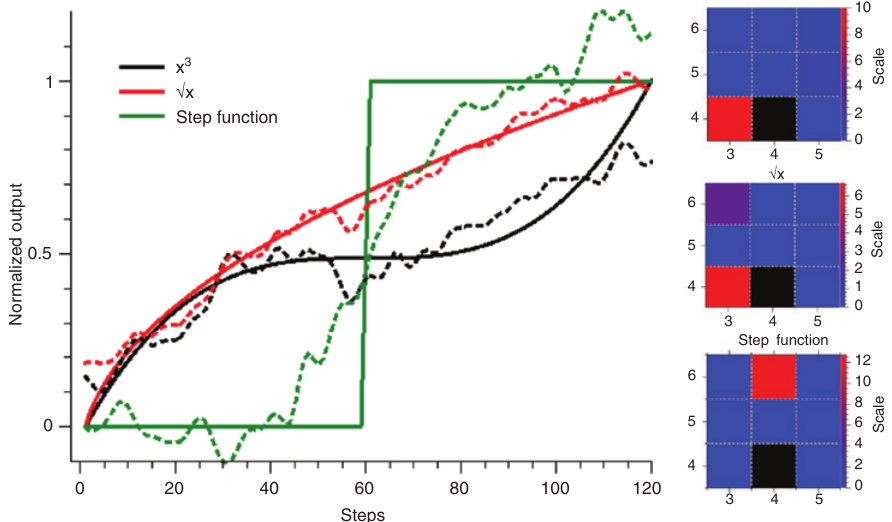
Figure 5: Several nonlinear transformations were synthesized from the network of eight injection locked lasers [24]. The y axis corresponds to rescaled values of optical intensities, the x axis to sample points of the input signal (sampling time 100 ps). The right panels show the numerically implemented readout weights of each individual